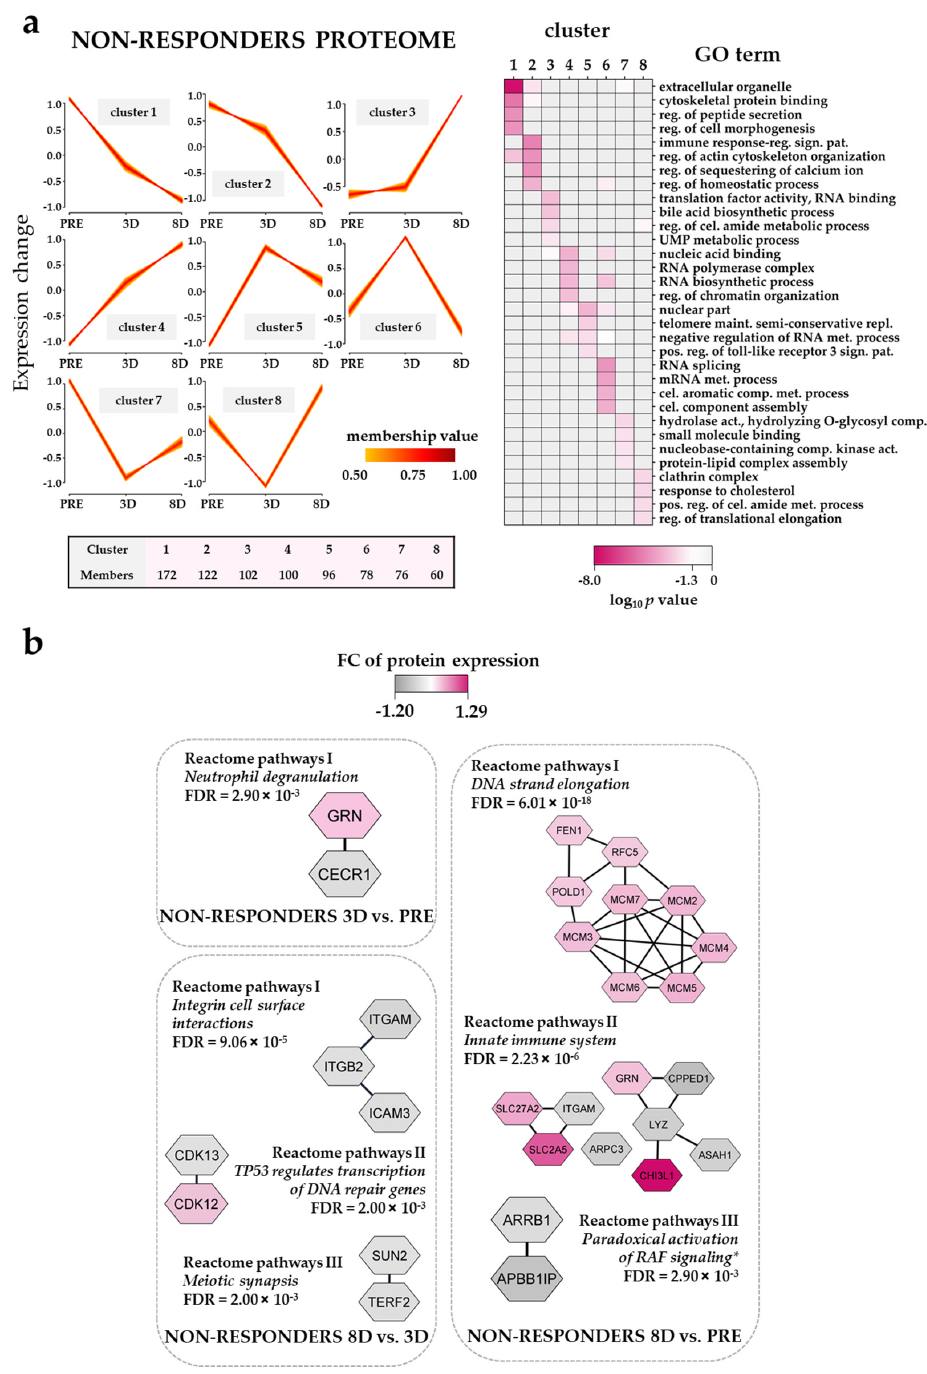
Figure 5. Protein expression profiles of non-responders before treatment (PRE) and after two days of ATRA treatment (3D) followed by ATRA–VP–TP treatment for five additional days (8D): ( a ) standard fuzzy c-means clustering of the protein expression profiles of non-responders at the three treatment time points and GO term enrichment analysis of each of the proteome clusters shown as a heatmap. Reg., sign., pat., cel., met., pos., comp., and act. were shortened from regulation, signaling, pathway, cellular, metabolic, positive, compound and activity, respectively, in the GO term nomenclature; ( b ) Reactome term enrichment of the regulated proteins identified in the differently temporal pair-wise comparisons were performed as indicated in the legend of Figure 4. * The full name of Reactome pathway III is paradoxical activation of RAF signaling by kinase inactive BRAF. The protein nodes are colored according to the corresponding 3D/PRE, 8D/PRE and 8D/3D